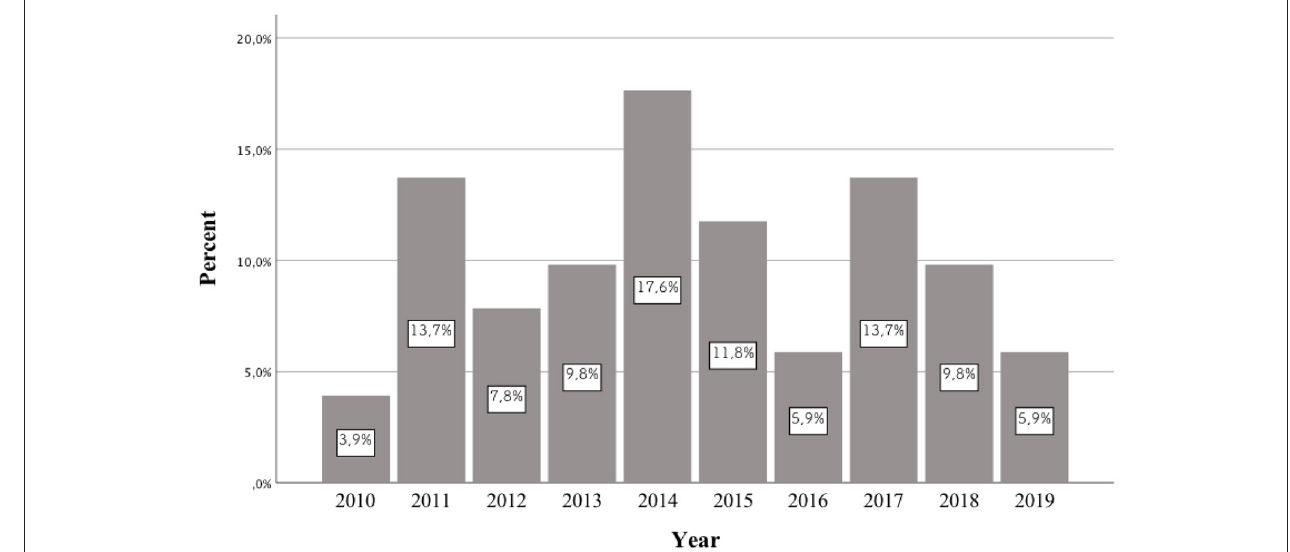
FIGURE 1 | Percentage of case reports concerning patients taking NPS written between 2010 and